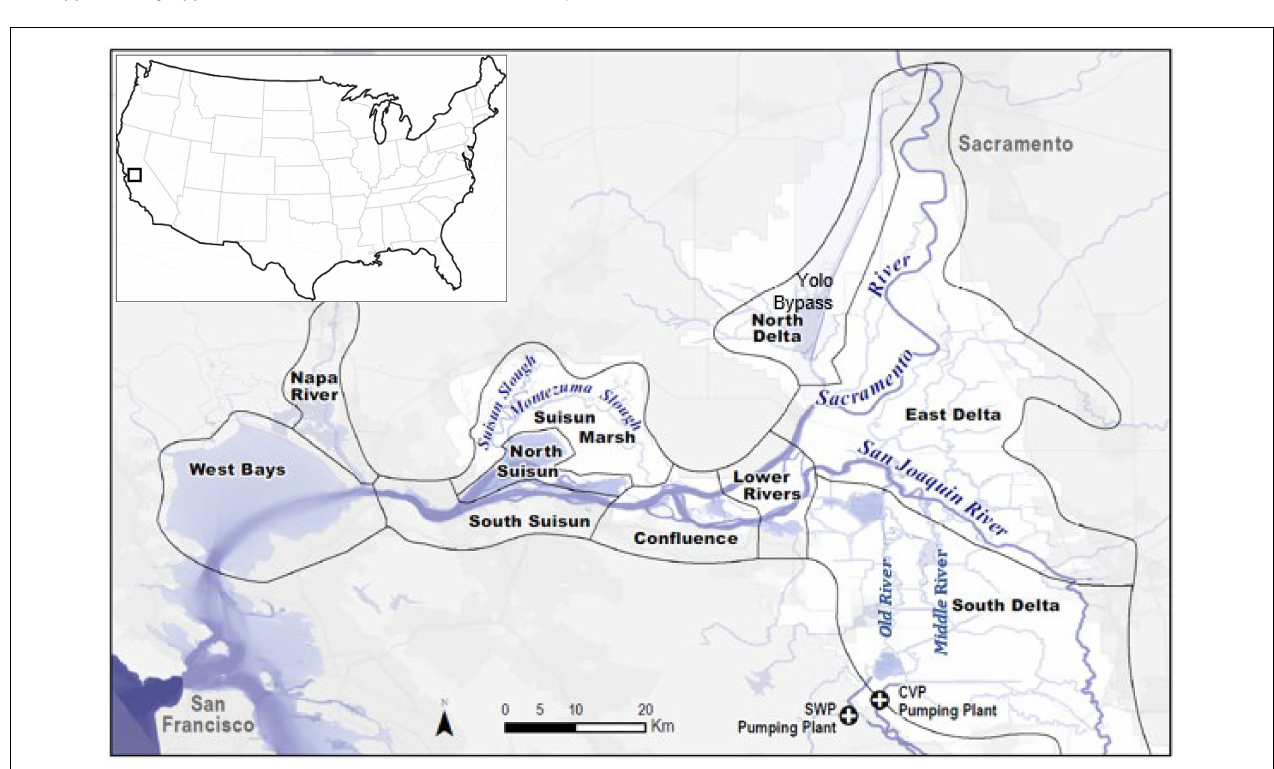
FIGURE 1 | The upper San Francisco Estuary, including the Sacramento-San Joaquin Delta, and its subregions.